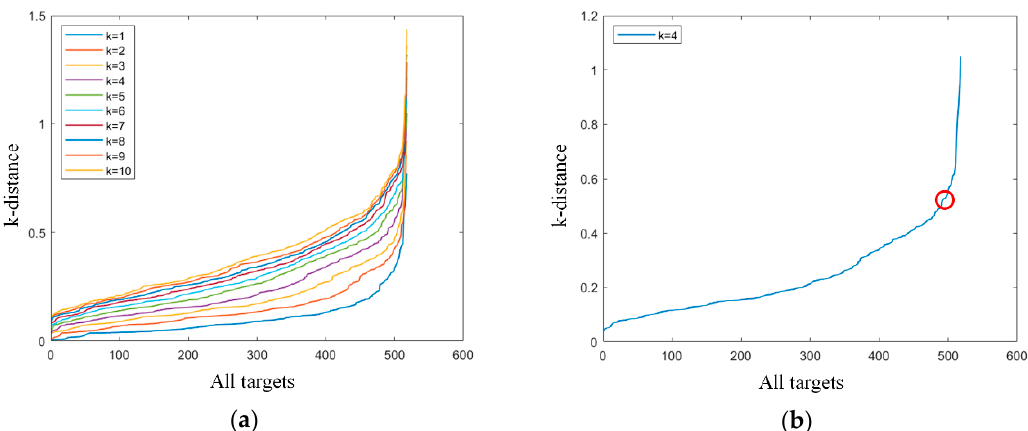
Figure 5. ( a ) Distance diagram with different K values; ( b ) Distance diagram with K = 4, where the circle is the position of “elbow.” circle is the position of